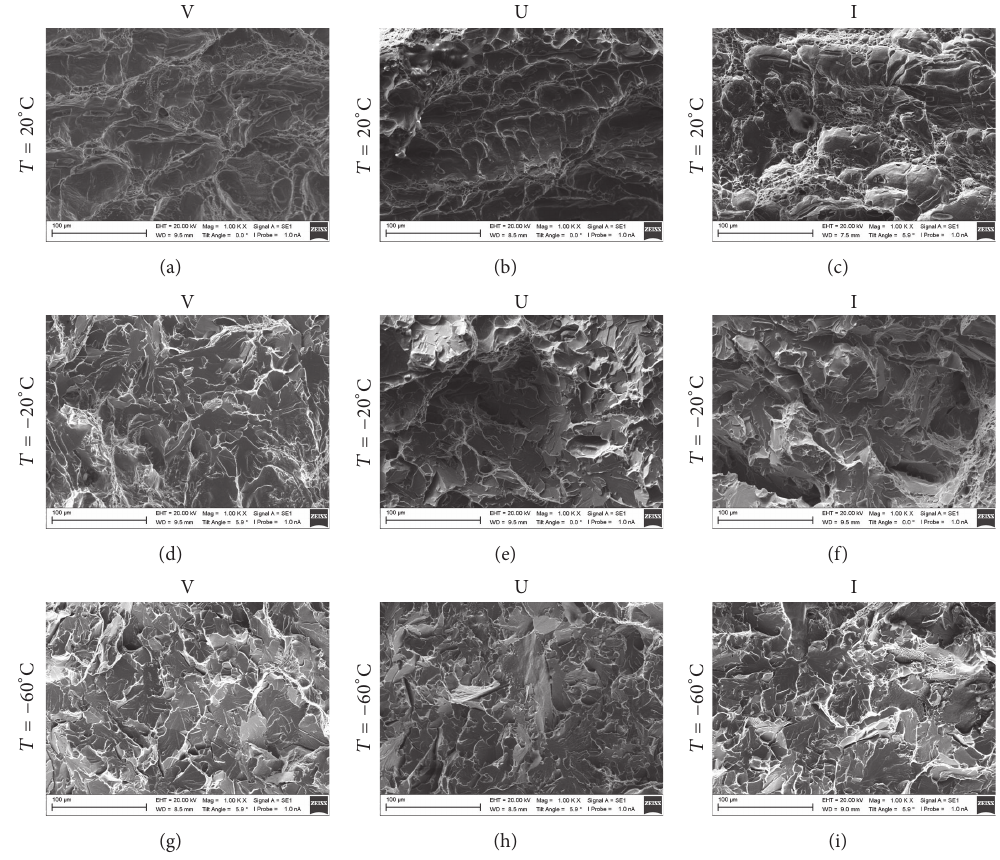
Figure 6: Fracture surfaces corresponding to the crack propagation zone in the specimens tested in impact bending at different temperatures.